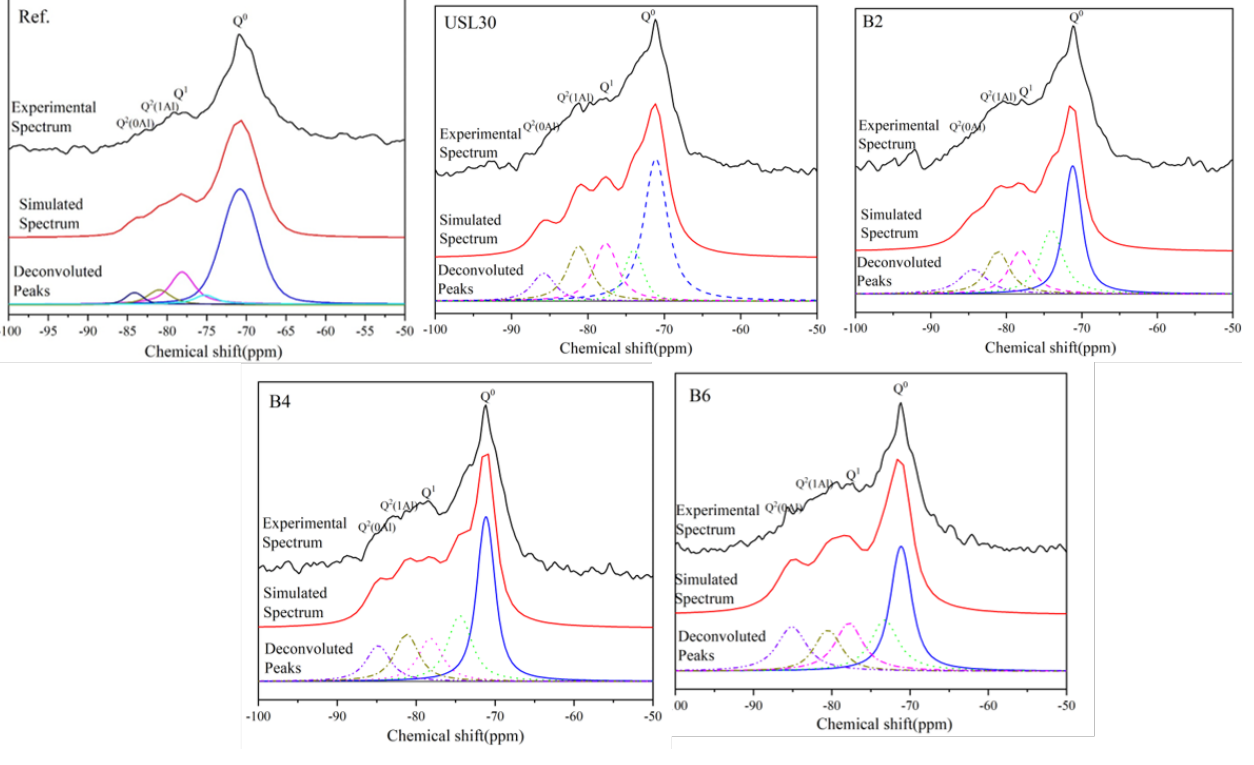
Figure 11. 29 Si NMR spectra of the Ref, USL30, B2, B4, and B6. Table 4. Deconvolution results for the 29 Si NMR spectra (%).